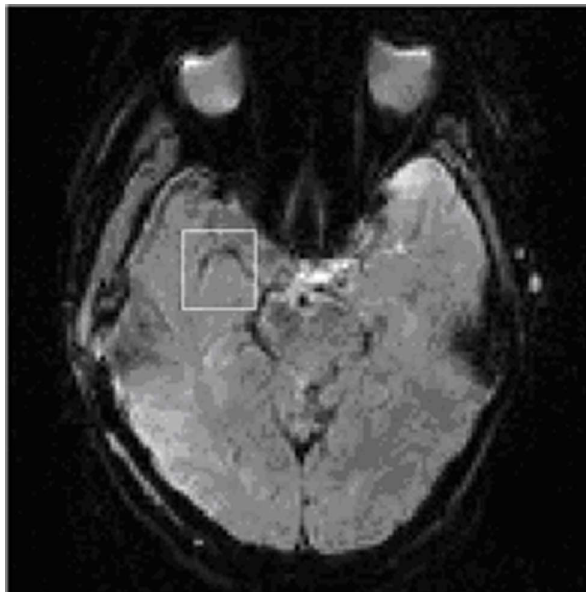
Figure 4. Image of a slice containing the right MCA (white rectangle) extracted from the first dynamic of perfusion scans for clustering analysis.